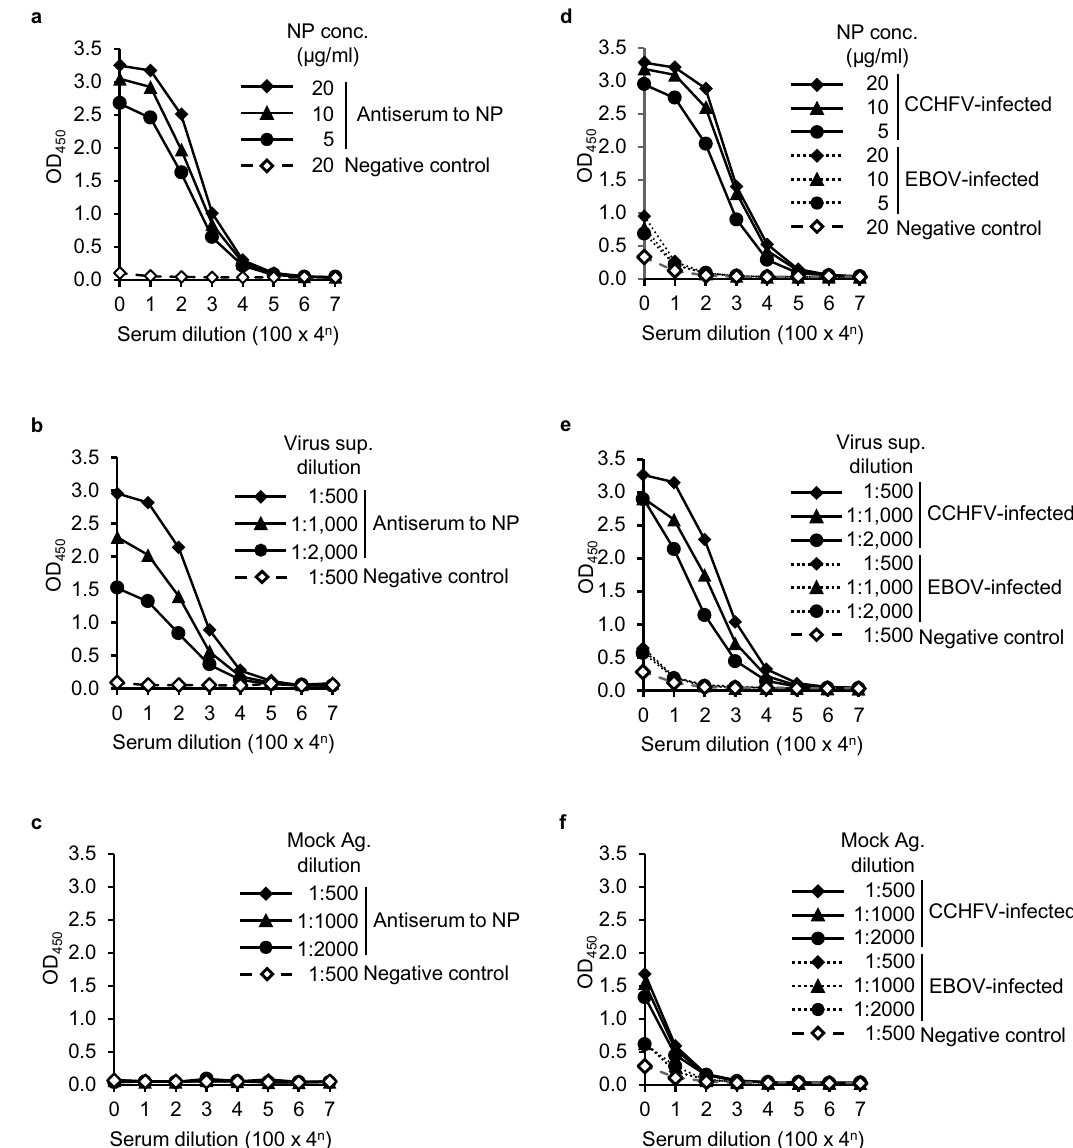
Figure 4. Detection of CCHFV NP-specific IgG in ELISA with purified CCHFV NP and whole CCHFV viral antigens. ELISA plates were coated with purified NP (5, 10, and 20 µg/ml) ( a , d ), serially diluted (1:500, 1:1,000, and 1:2,000) CCHFV-infected cell culture supernatant (Virus sup.) ( b , e ), or mock-infected supernatant (Mock Ag.) ( c , f ). Serial dilutions of the rabbit antiserum ( a , b , c ) and CCHFV-infected monkey serum ( d , e , f ) were used as primary antibodies, followed by detection with HRPO-conjugated anti-rabbit IgG and anti-monkey IgG antibodies, respectively. Negative control rabbit and monkey sera and EBOV-infected monkey serum were also